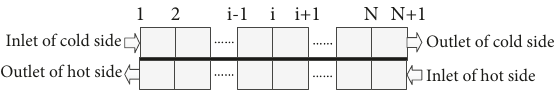
Figure 6: SCTRAN/CO2 nodalization for PCHE.